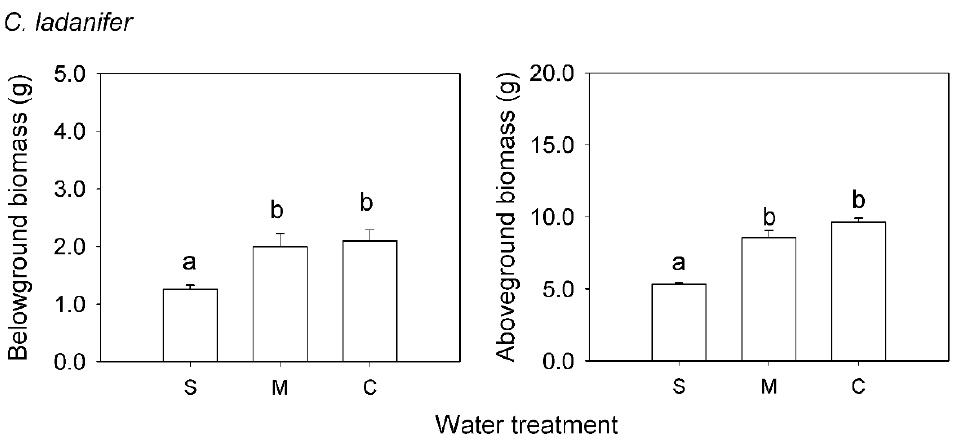
Figure A1. Belowground and aboveground biomass of A. pourretti , T. barbata , O. compressus and C. salviifolius in severe water deficit, moderate water deficit and control. Significant differences at p < 0.05 are indicated by different letters. n.s., not significant.